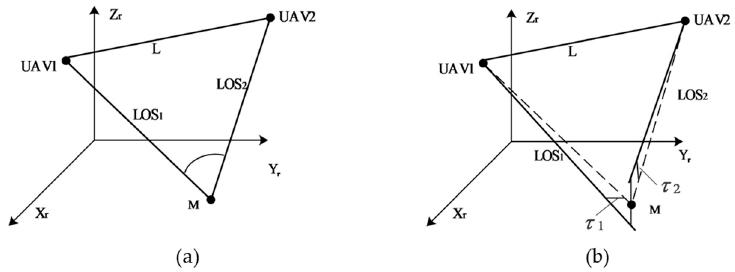
Figure 6. Positional relationship of the two visual axes. ( a ) rendezvous; ( b ) non-uniplannar intersection.